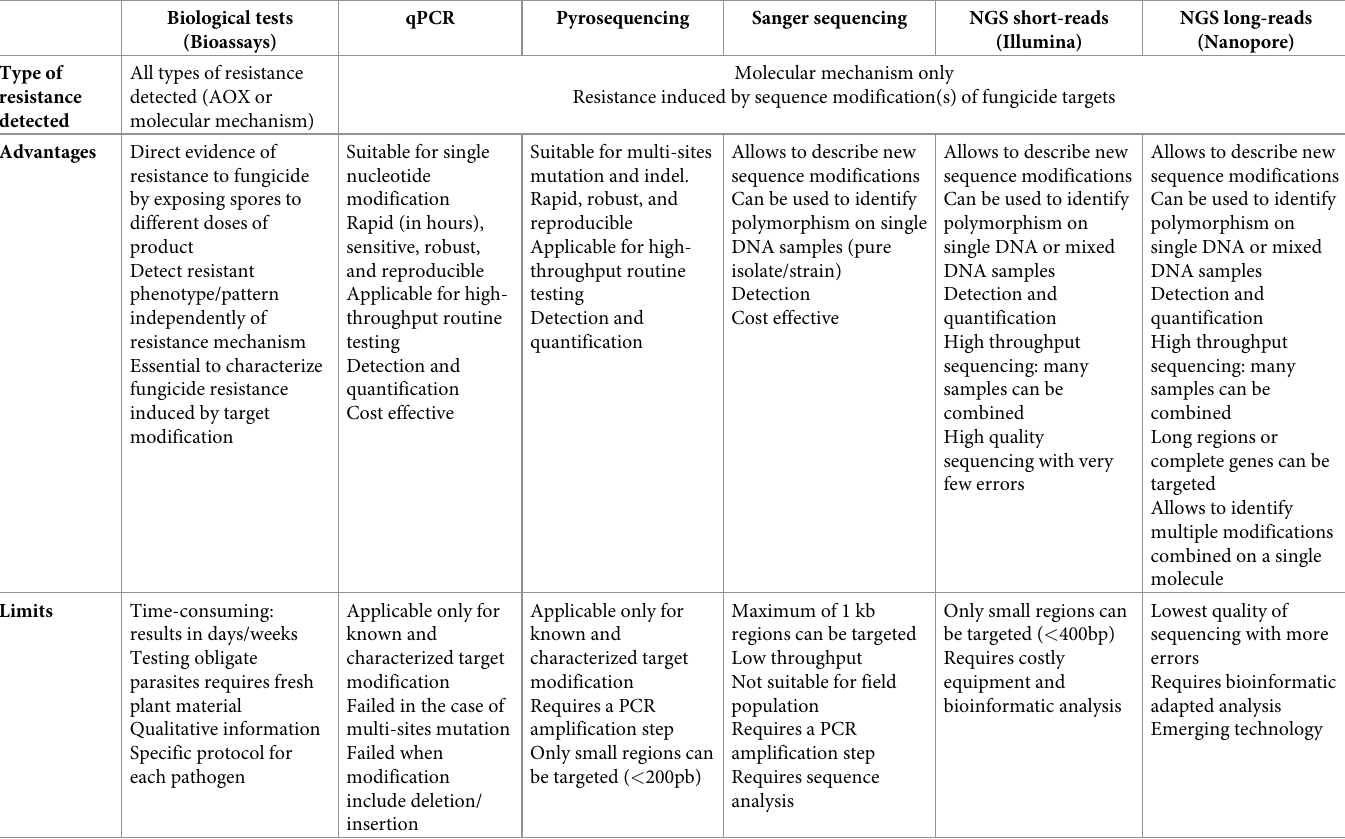
Table 4. Comparison of tools used for characterising fungicide resistance mechanisms in